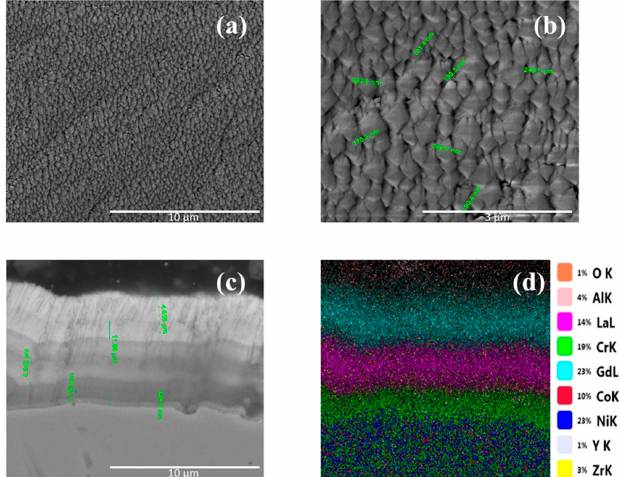
Figure 5. SEM images (50,000×), QUANTA INSPECT F50, FEI Company, Eindhoven, The Netherlands, representing: ( a ) and ( b ) the surface of the NiCrAlY/YSZ/LZO/GZO coating deposited on Nimonic substrate at different magnifications; ( c ) the section view of NiCrAlY/ZrO2-RE1/LZO/GZO type deposition on Nimonic substrate, and ( d ) the elemental mapping.